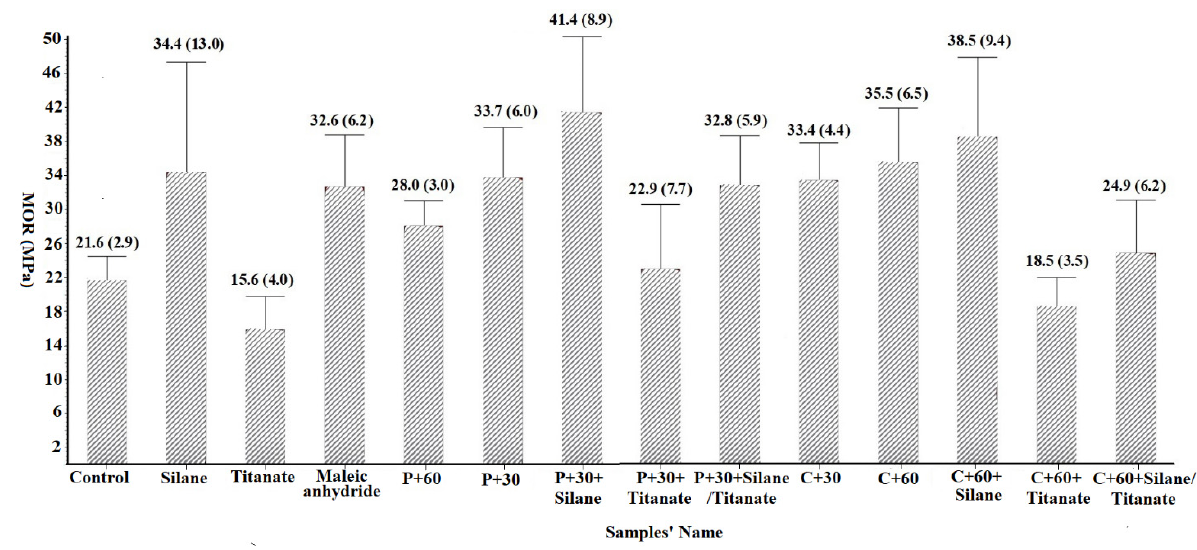
Figure 5. The Modulus of rupture (MOR) of composites (Values represent means of 10 replicates/test. Values in parentheses represent one standard deviation; the detail for samples’ name shown in Table 1).